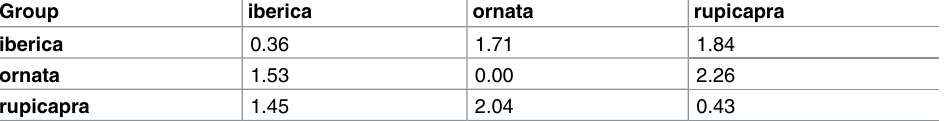
Table 2. Mean pairwise nucleotide differences using the correction of Jukes-Cantor, among Rupica- pra population groups. Group iberica ornata rupicapra iberica 0.36 1.71 1.84 ornata 1.53 0.00 2.26 rupicapra 1.45 2.04 0.43 Values have been multiplied by 1000. Above diagonal: Differences between populations(PiXY). Diagonalelements: Differences within population (PiX). Below diagonal: Corrected average pairwise difference